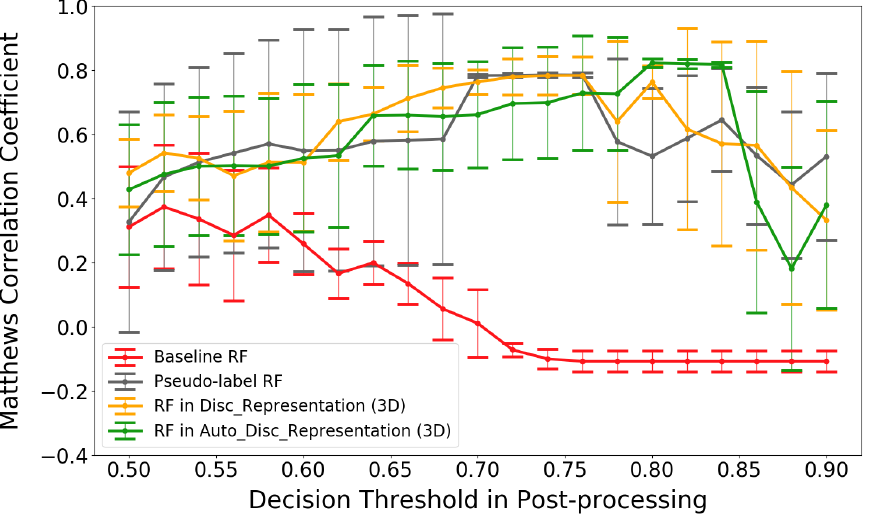
Figure 8. Classification results (using MCC) for post-processing with different decision thresholds. Error bars indicate standard